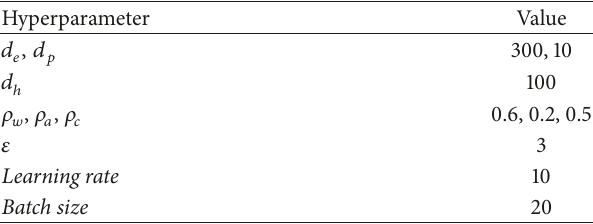
Table 1: Hyperparameter